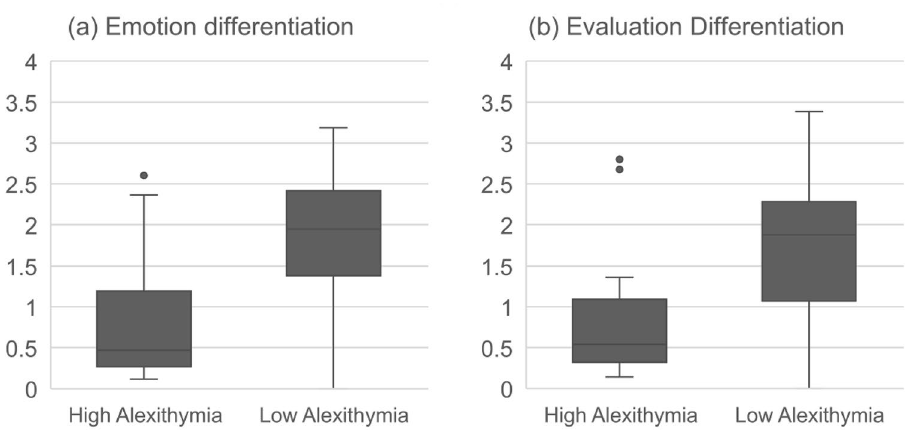
Figure 1. Boxplot for ( a ) Emotion Differentiation, and ( b ) Evaluation differentiation scores by alexithymia groups (High vs. Low) in Study 1. Low scores mean that participants’ ratings tended to be similar across different emotions (fear, anger, disgust, sadness) or evaluations (dangerous, offensive, foul, irrevocable